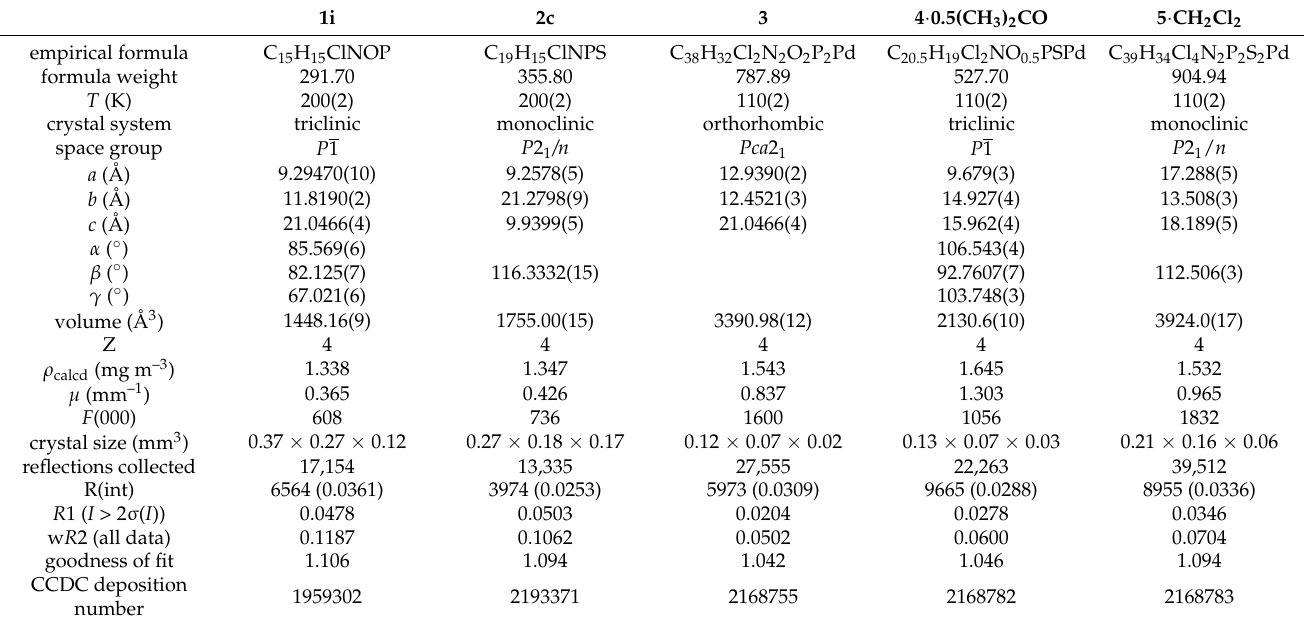
Table 1. Crystallographic data and details of structure refinement parameters of 1i , 2c , and 3 –